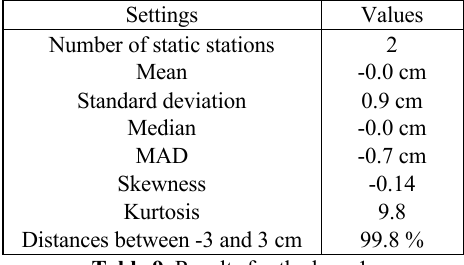
Table 9. Results for the loop